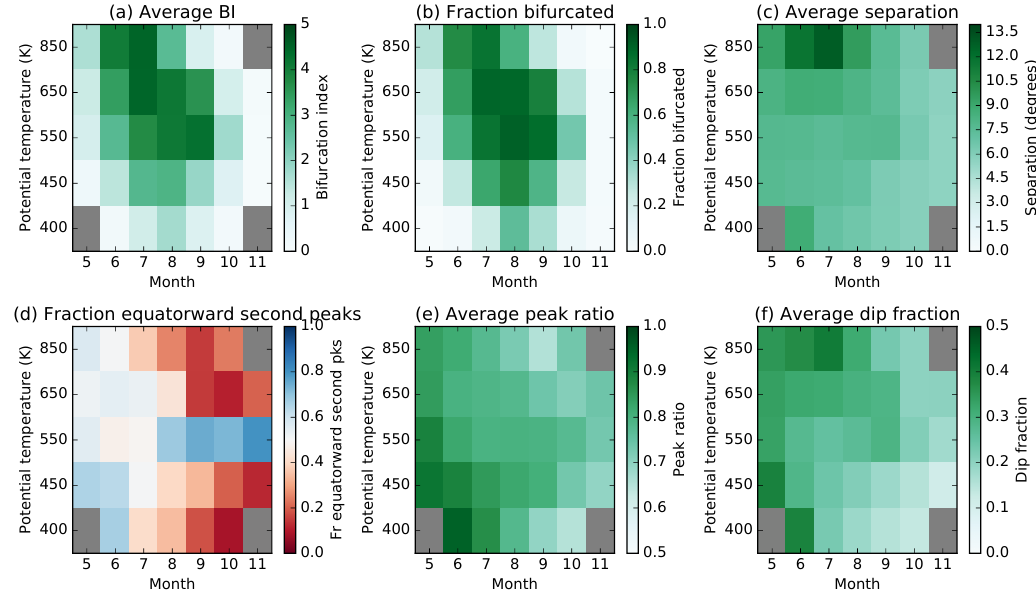
Figure 7. Climatological structure and seasonal evolution of bifurcation metrics at CFSR levels between 400 and 850K, 1979–2016. Months/levels with less than 1% of bifurcated profiles are shaded in grey.